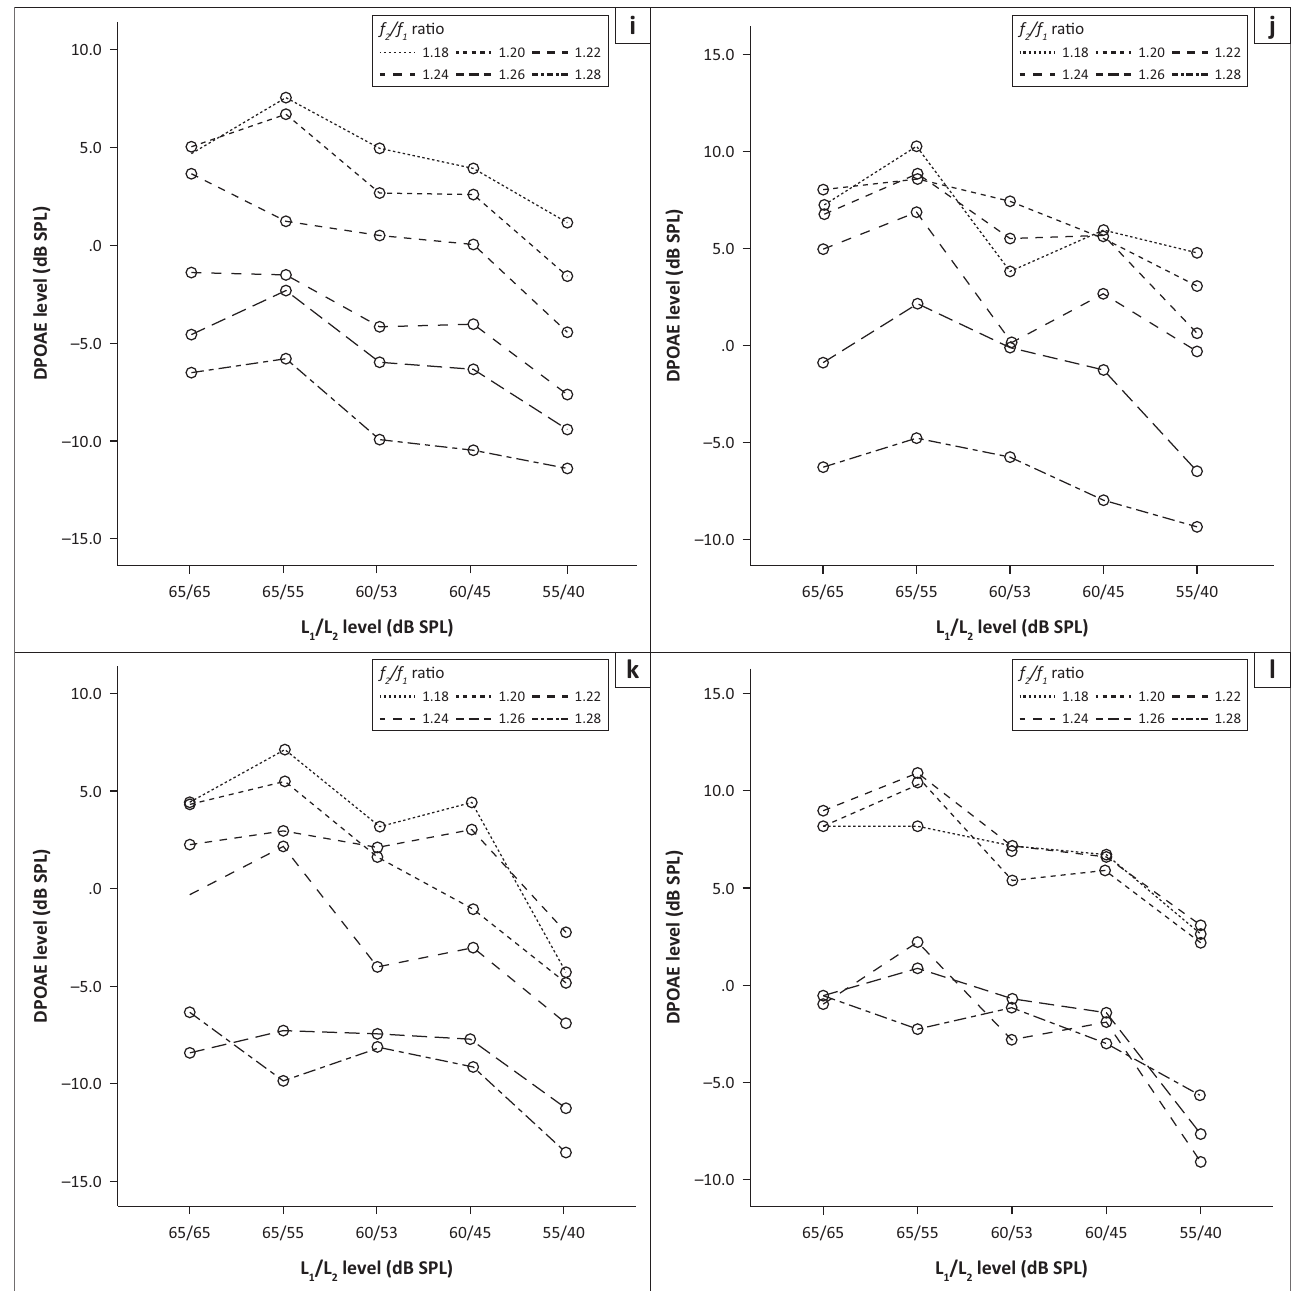
FIGURE 1 (Continues...): Mean distortion product otoacoustic emission absolute levels per intensity and frequency ratio combinations for each frequency ( f ear at 2003 Hz, (b) left ear at 2003 Hz, (c) right ear at 2519 Hz, (d) left ear at 2519 Hz, (e) right ear at 3175 Hz, (f) left ear at 3175 Hz, (g) right ear at 3996 Hz, (h) left ear at 3996 Hz, (i) right ear 5000 Hz, (j) left ear at 5000 Hz, (k) right ear at 6996 Hz, (l) left ear at 6996 Hz, (m) right ear at 8003Hz and (n) left ear at 8003Hz. Hz,